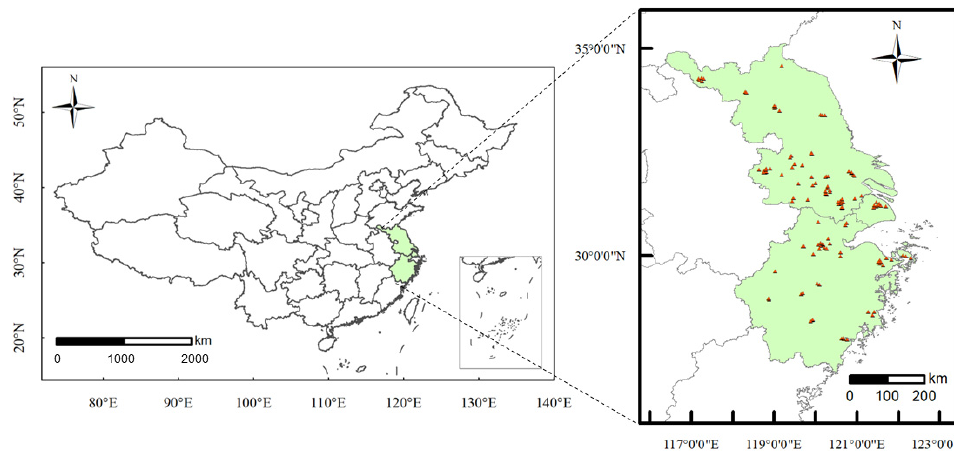
Figure 1. Geographical location of the study area and spatial distributions of 123 air quality moni- toring